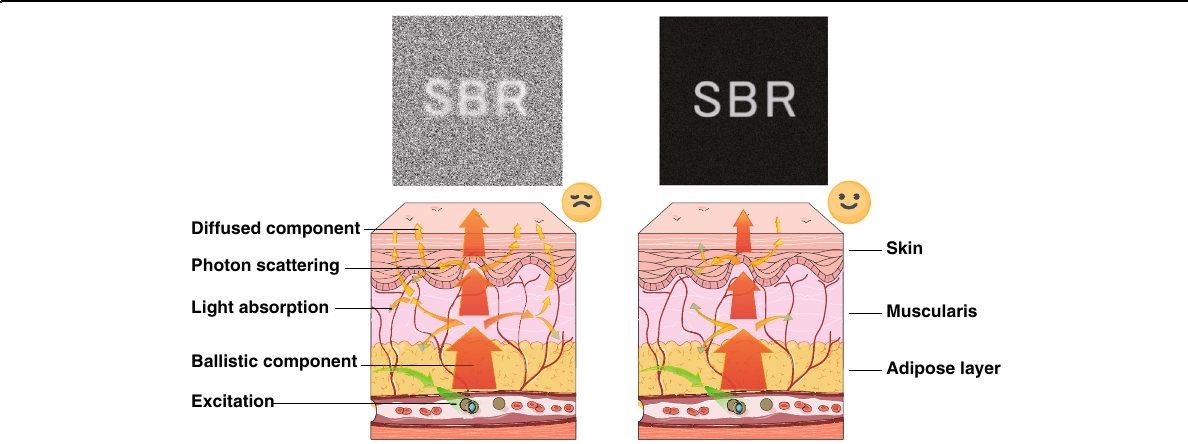
Fig. 1 Schematic diagram of light propagation in tissue. The propagation of excited ballistic and diffused emission photons in the bio-tissue with small (left) and moderate (right) light absorption and the resulting signal-to-background ratios (SBRs) of fl uorescence